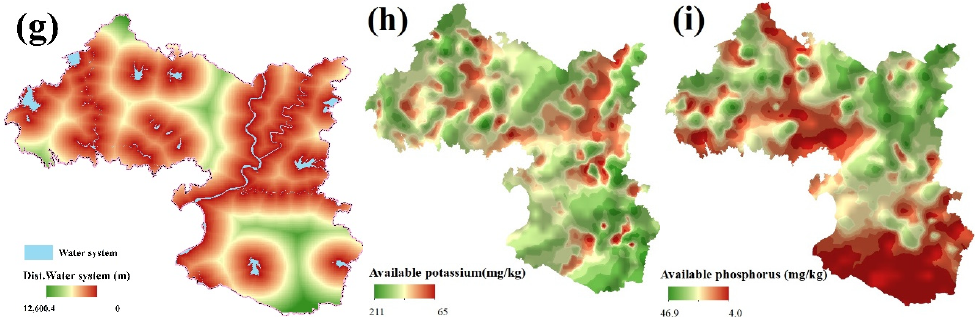
Figure 3. The spatial distribution of artificial factors in the research region: ( a ) suspected soil pollution sources; (b) suspected water pollution sources; ( c ) suspected air pollution sources; ( d ) livestock farm; ( e ) mining area; ( f ) road; ( g ) water system; ( h ) available potassium; ( i ) available